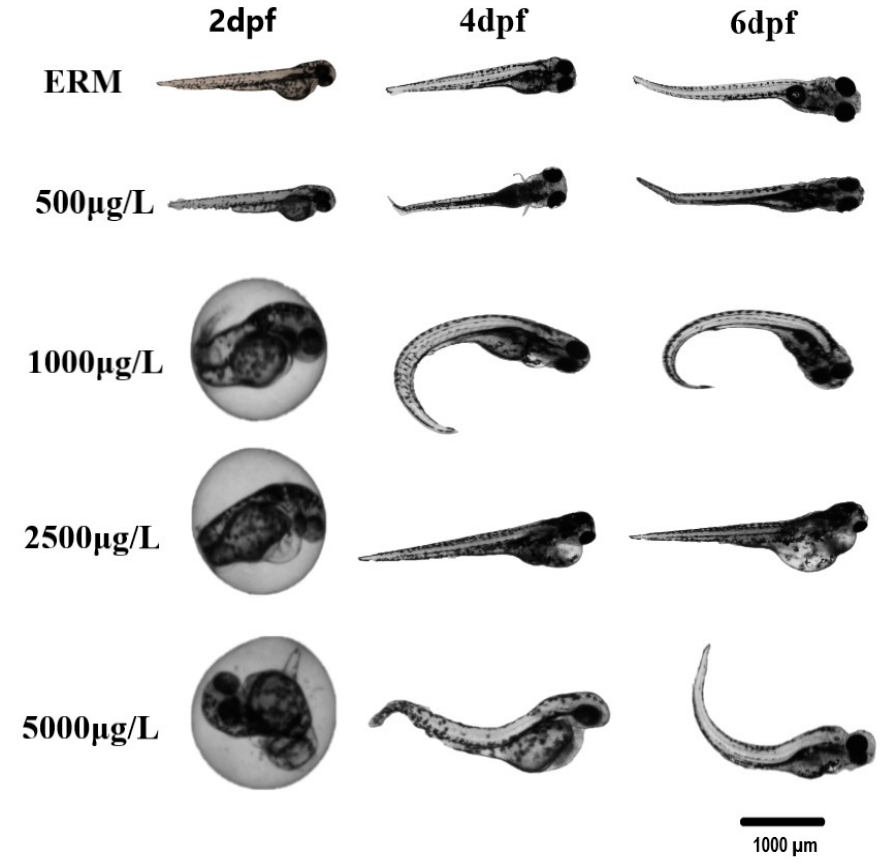
Figure 2. Selected photomicrographs of morphological deformities observed in zebrafish em- bryos/larvae at 2, 4, and 6 dpf after being exposed to one concentration of 500, 1000, 2500, and 5000 µ g/L sulfamethoxazole and ERM (control). The scale bar is 1000 µ m. Most of the deformi- ties/malformations were observed at higher concentrations tested. Predominant deformities were yolk sac edema, pericardial effusion, bent tail, and curved spine.